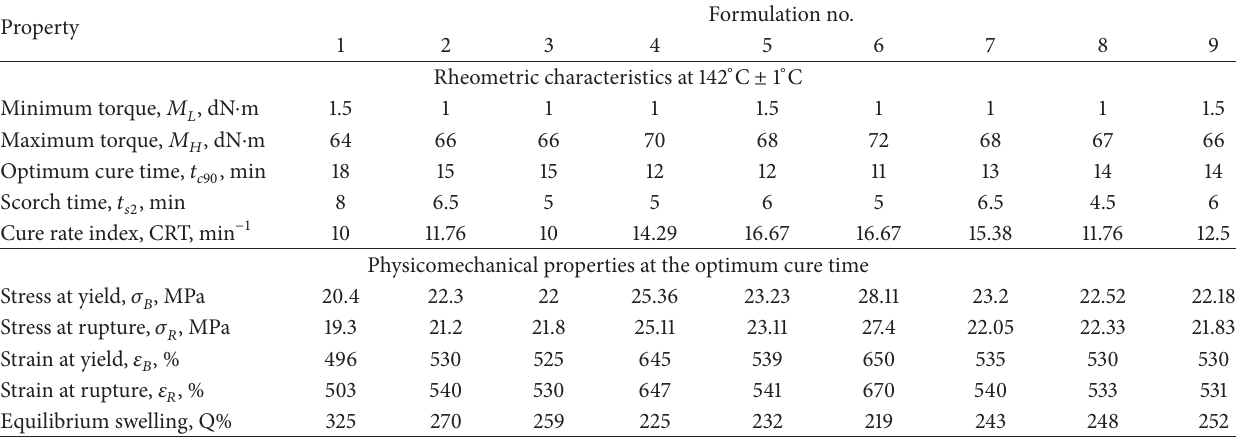
Table 2: Rheometric characteristics and physico-mechanical properties of NR vulcanizates containing the prepared homopolymers and copolymers.